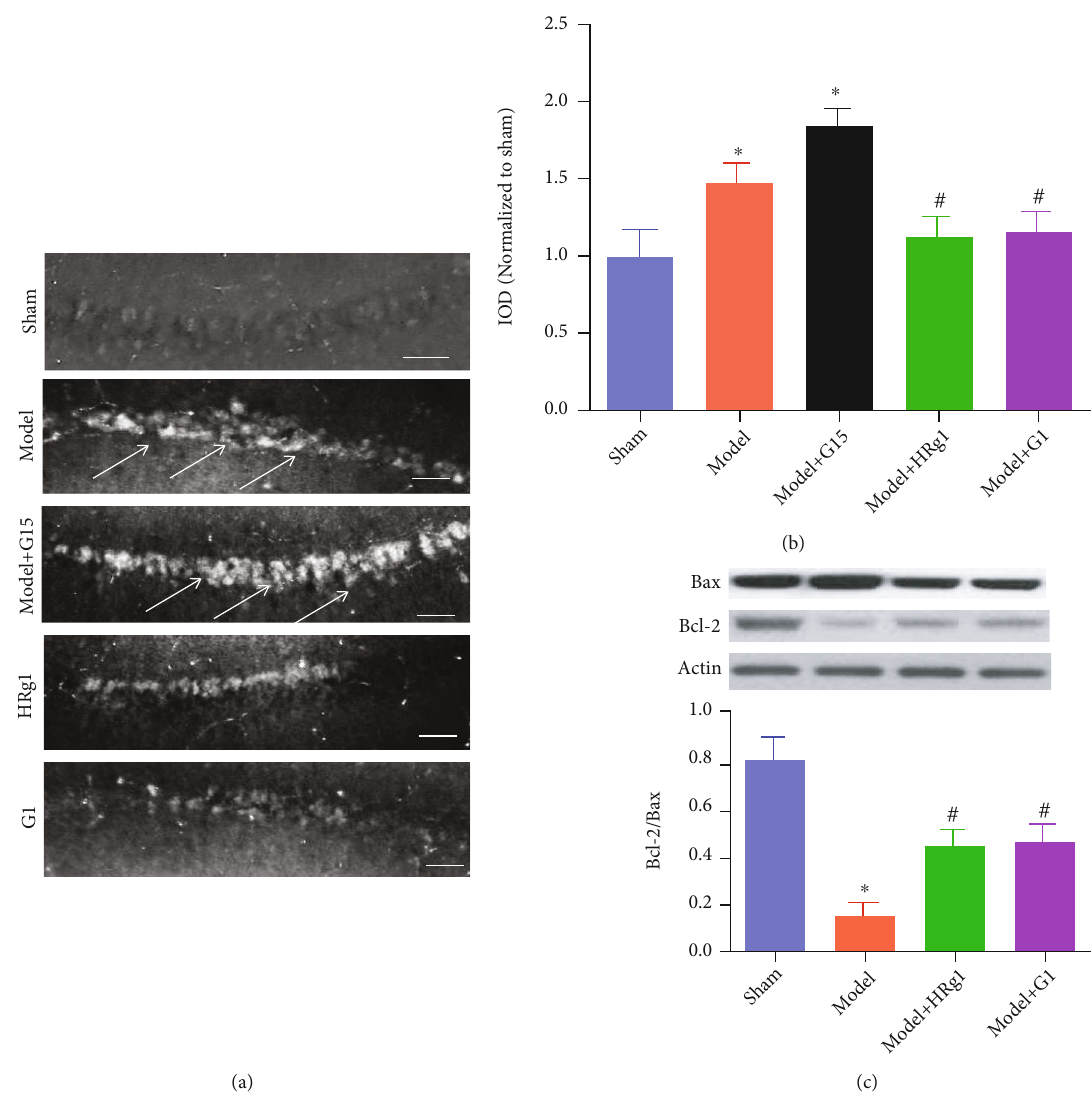
Figure 6: Ginsenoside Rg1 inhibited hippocampal neuronal apoptosis induced by BCAS modeling. (a) TUNEL staining; arrows indicate the apoptotic cells; scale bar: 50 μ m. (b) Apoptotic cell count; (c) Bcl-2/Bax expression level and representative bands of Bcl-2 and Bax. ∗ P < 0 : 05 , vs. the sham group, # P < 0 : 05 , vs. the model group ( N = 5 in each